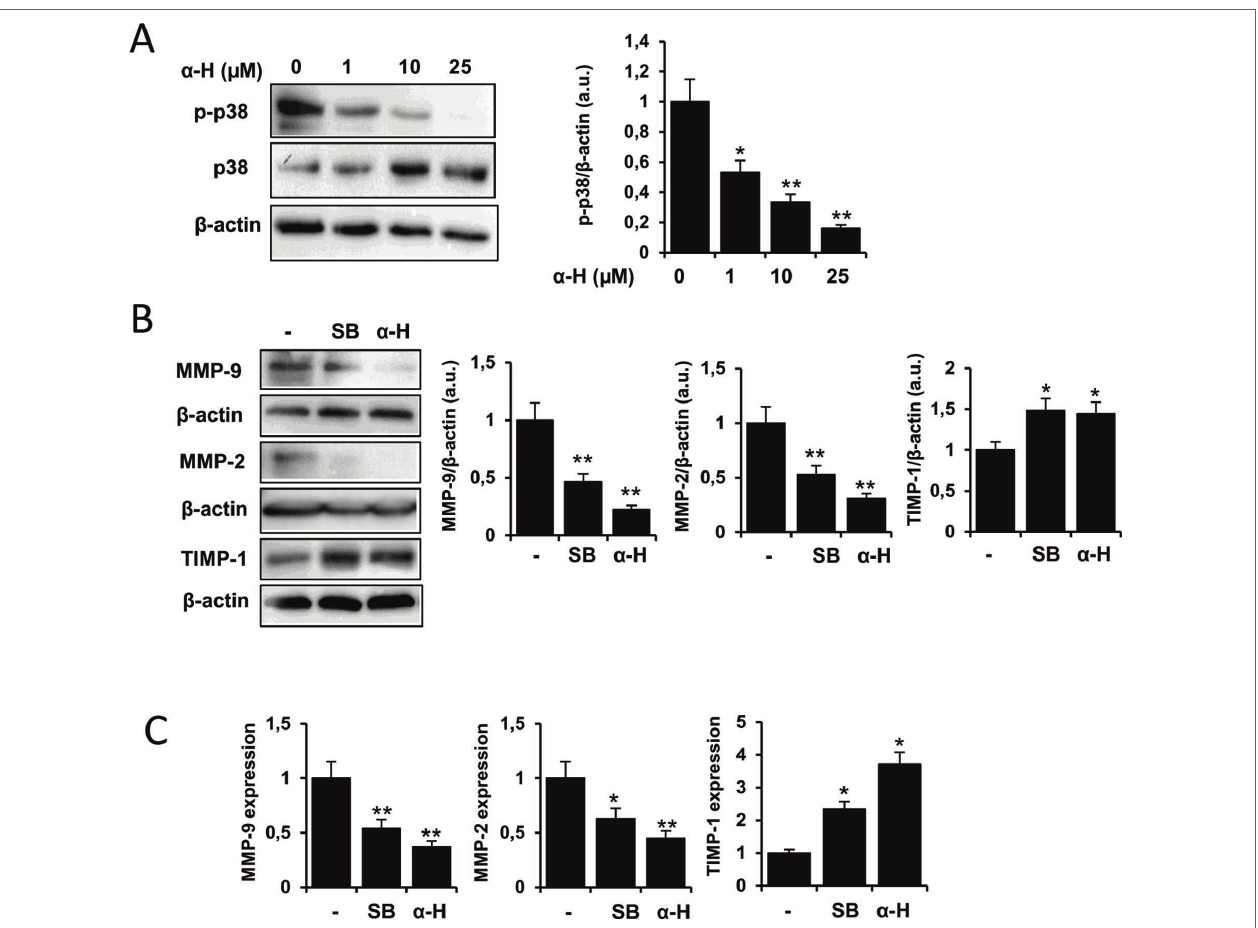
FIGURE 7 | α -H treatment inhibited p38MAPK signal showing similar effects on MMPs and TIMP-1 expression as a specific p38MAPK inhibitor. (A) U87 cells were treated with different concentrations of α -H (1, 10, and 25 μM) or vehicle as control for 24 h. p-p38 and p38 protein levels were determined by Western blot. β -actin was used as loading control. A representative experiment is shown of three performed. Bars graphs show densitometry quantification of the bands and represent means ± S.D. from three independent experiments. (B) Cells were treated with a specific p38MAPK inhibitor (SB202190, 10 μM) or α -H (25 μM) for 24 h. MMP-9, MMP-2, and TIMP-1 protein levels were determined by Western blot. β -actin was used as loading control. A representative experiment is shown of three performed. Bars graphs show densitometry quantification of the bands and represent means ± S.D. from three independent experiments. (C) mRNA expression of MMP-9, MMP-2, and TIMP-1 was determined by quantitative PCR on U87 cells treated as in B. Values represent the means ± S.D. of three independent experiments performed in triplicate. *P < 0.05 and **P < 0.01 with respect to the non-treated